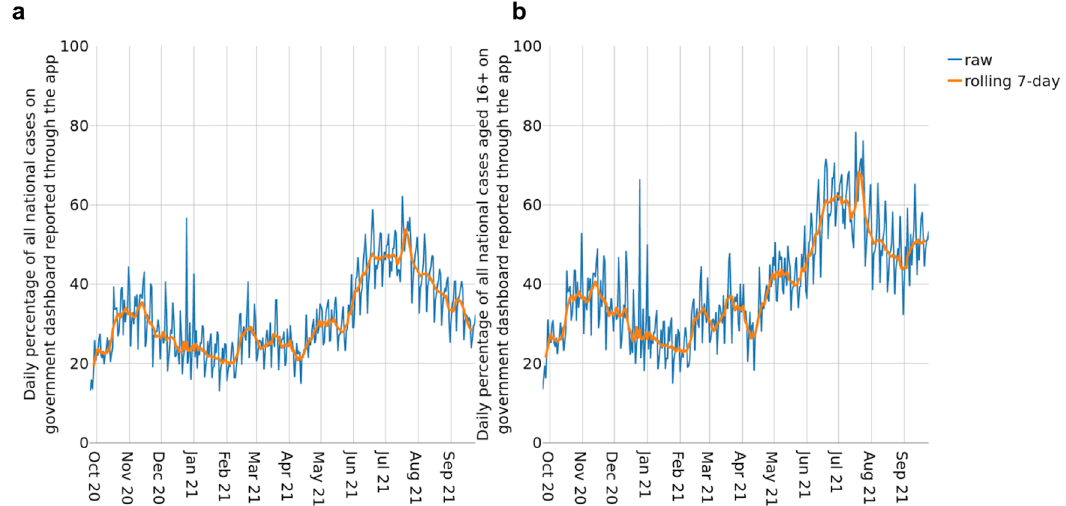
Fig.3|Positivetestsreportedthroughtheapp.a ThepercentageofallpositivetestsbyspecimendatereportedinEnglandandWalesthatareapp-reportedcases. b The estimated percentage of positive tests by specimen date amongst those aged 16 or over in England and Wales that are app-reported cases.